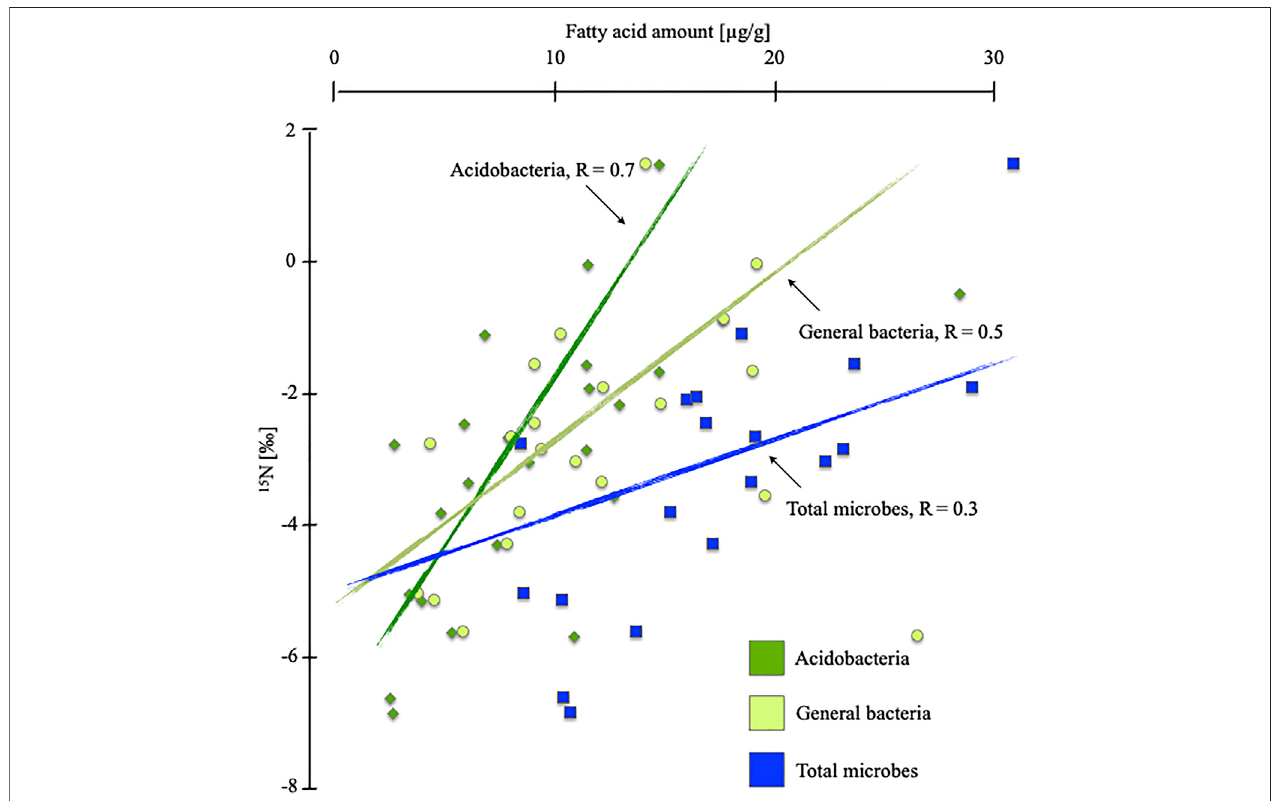
FIGURE 4 | Spearman correlation index (R) and correlation of δ 15 N [ ‰ ] and microbial, general bacterial and acidobacterial membrane fatty acid marker amount [µg/g], for the rewetted site in Degerö Stormyr and the drained site in Lakkasuo.